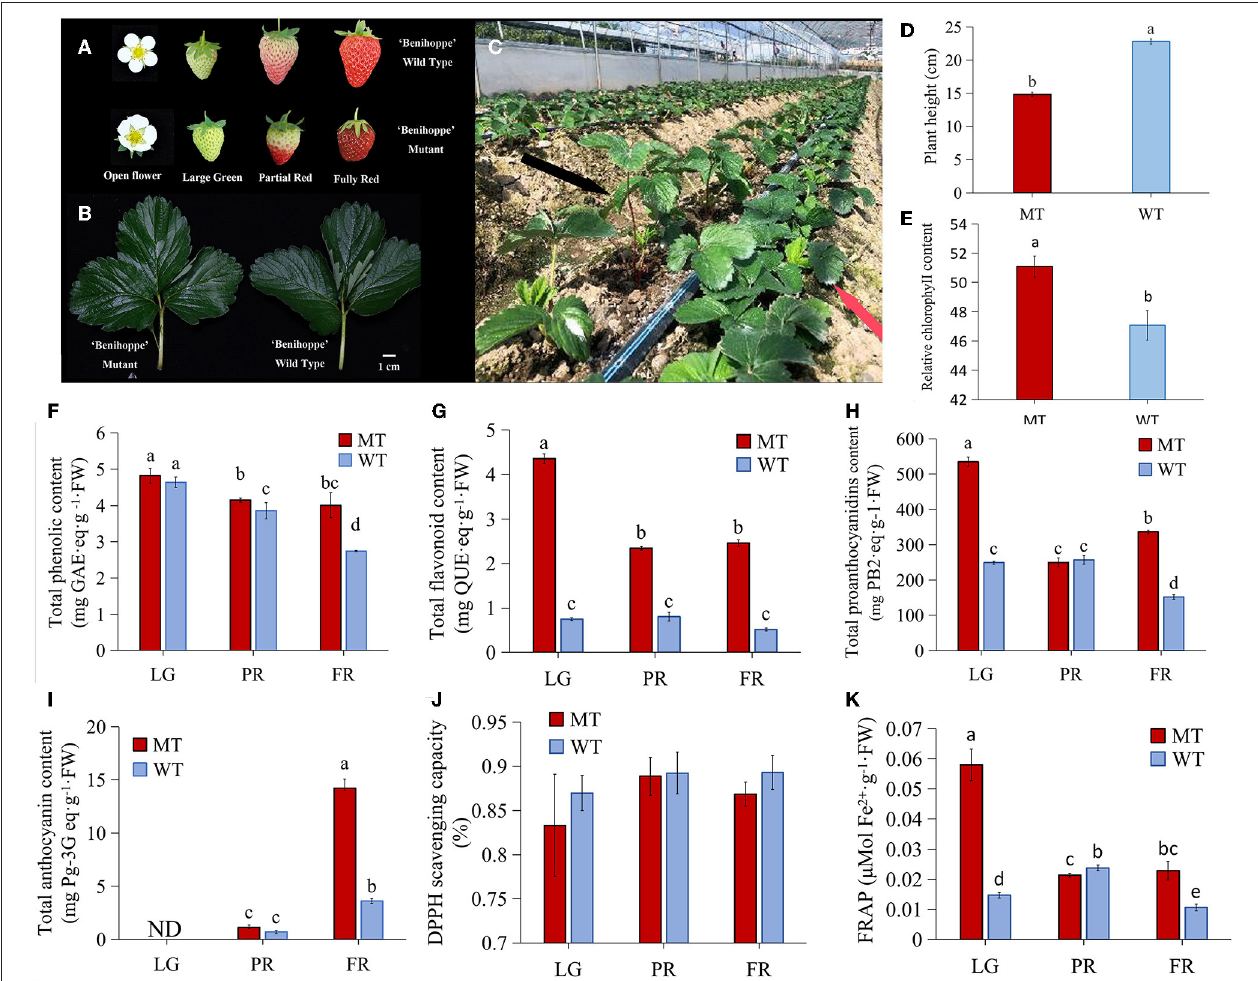
FIGURE 1 | The differences between strawberry ‘Benihoppe’ and its mutant. (A,B) The phenotype of flowers, fruits and leaves; (C) The phenotype of mutant plants (red arrow) and ‘Benihoppe’ plants (black arrow); (D,E) The plant height and relative chlorophyll content; (F,G) The total phenolic content and total flavonoid content; (H,I) Total anthocyanins content and total proanthocyanidins content; (J) The DPPH scavenging capacity; (K) FRAP antioxidant capacity of strawberry ‘Benihoppe’ and its mutant at different developmental stages. ND, not detected; LG, large green; PR, partial red; FR, fully red; MT and WT indicated mutant and normal ‘Benihoppe’ separately. The same as